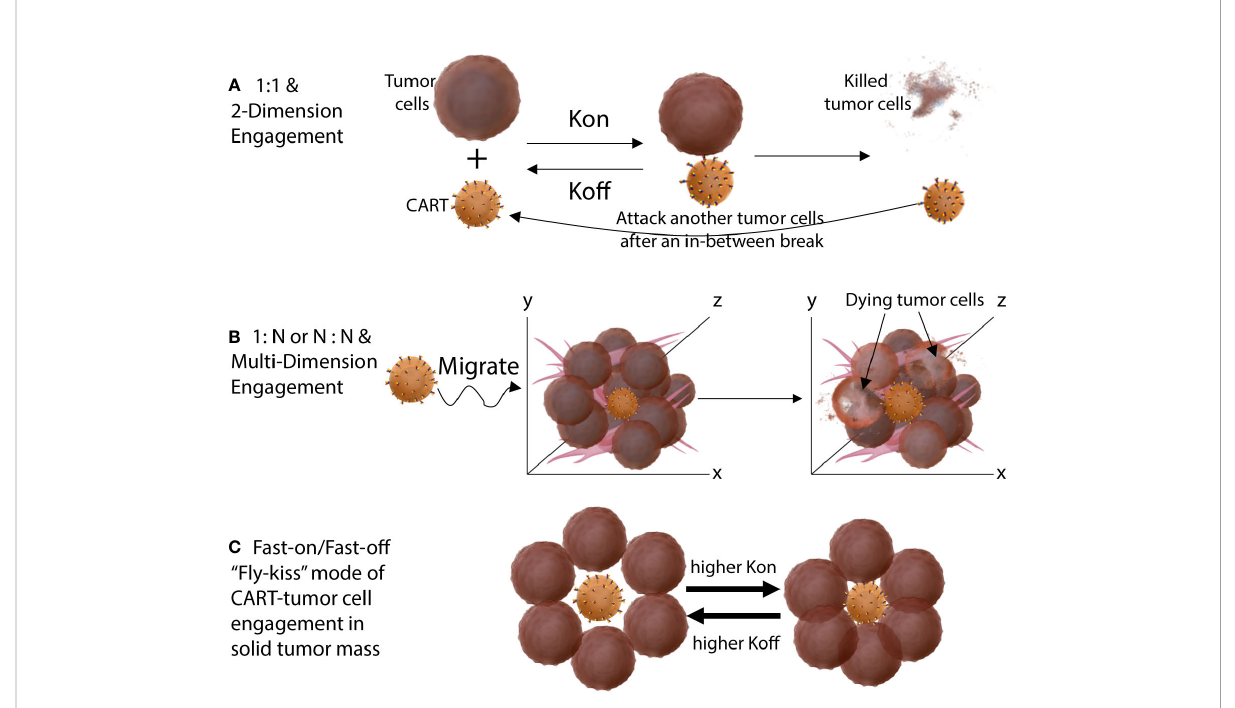
FIGURE 3 Different engagement modes of CART-tumor cells in hematological cancers (A) and in solid tumors (B) . The CARTs engage tumor cells in a solid tumor mass in 1-on-N or N-on-N multi-dimensional mode. (C) The fast-on/fast-off (bind-off-rebind) “ fl y-kiss ” style of CART-tumor engagement when both the K on and K off is high. High K off allows CARTs to disengage from tumor cells even they are surrounded in solid tumors. High K on make sure that CART will re-engage tumor cells even when tumor antigen level is